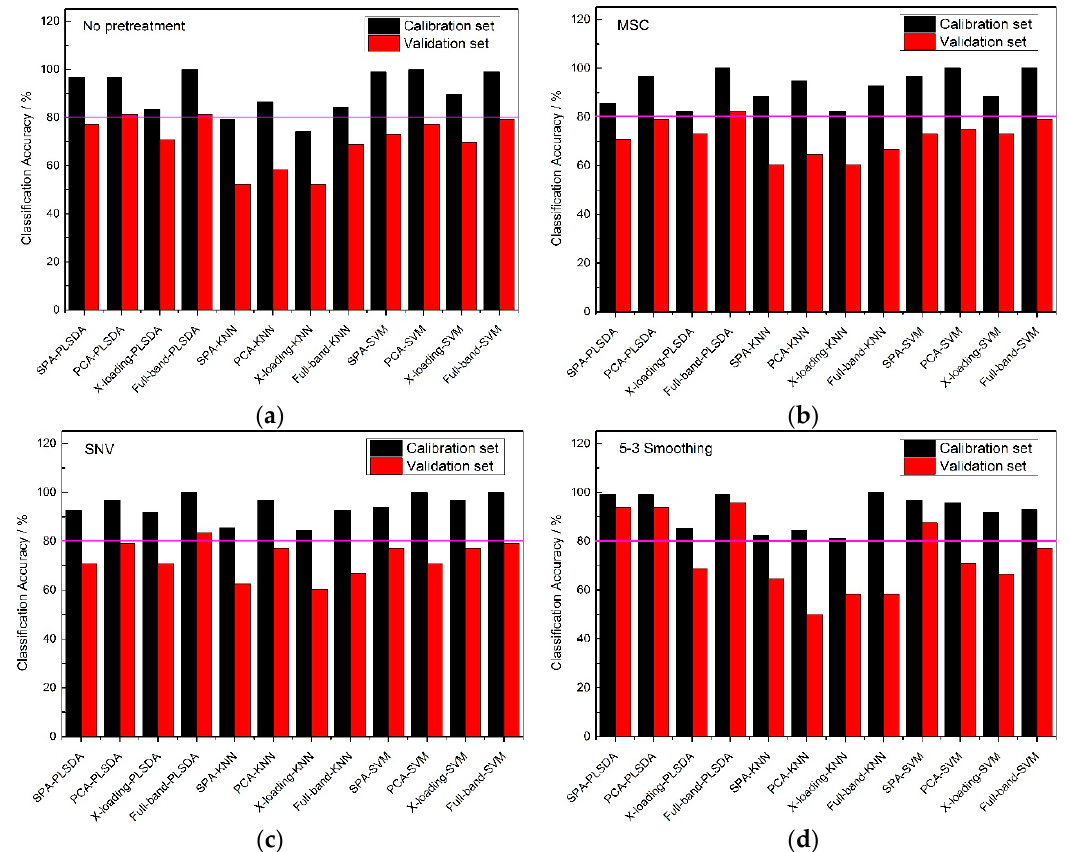
Figure 6. The classification accuracy results of Jindan10 with ( a ) no pretreatment method, ( b ) the MSC pretreatment method, ( c ) the SNV pretreatment method and ( d ) the 5-3 smoothing pretreatment method.